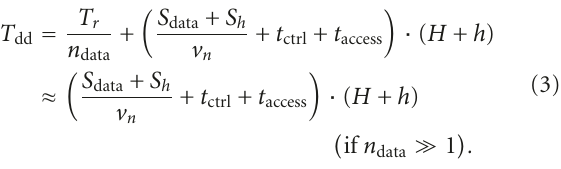
Figure 6: Gradients to the sink. (a) Before reinforcement. (b) After reinforcement.